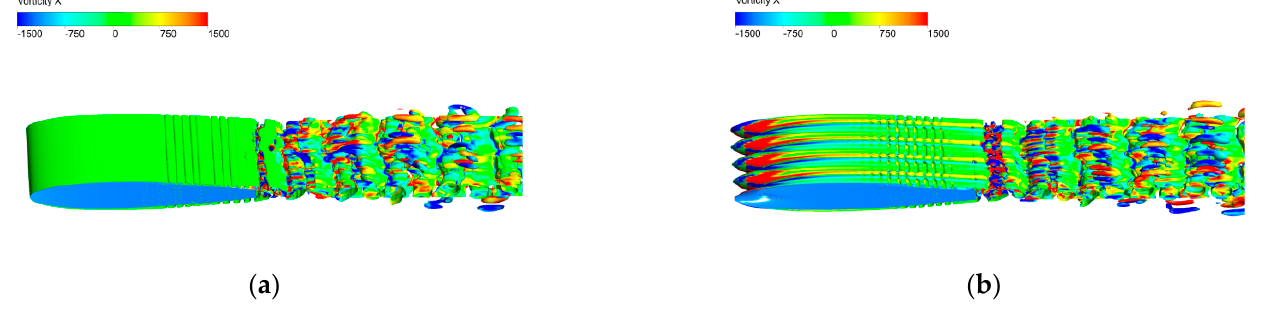
Figure 15. Iso-surfaces of the Q -criterion ( Q = 150,000 s − 2 ) colored by the streamwise vorticity: ( a ) BaselineBlunt; ( b ) A10W10Blunt.